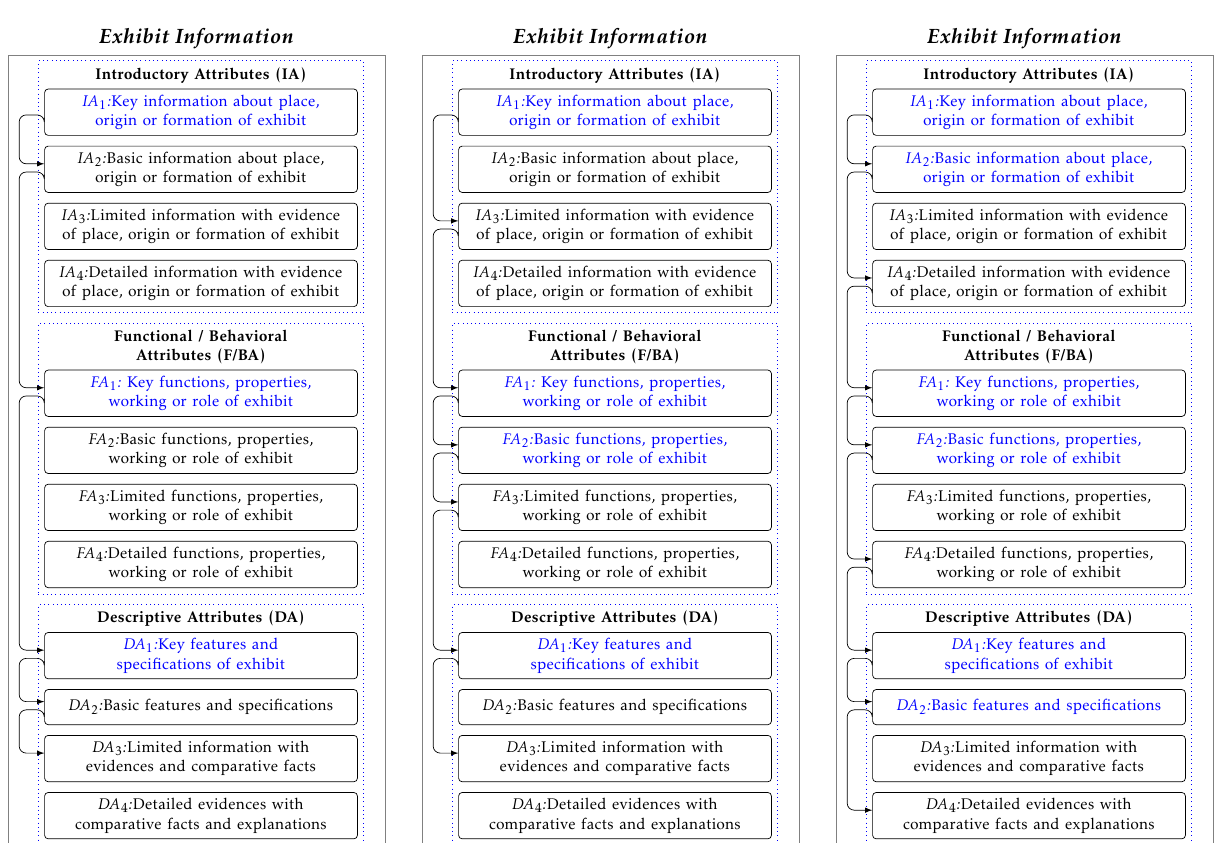
Figure 2. Organization Layout Figure 3. Organization Layout for College Figure 4. Organization Layout for Profes-